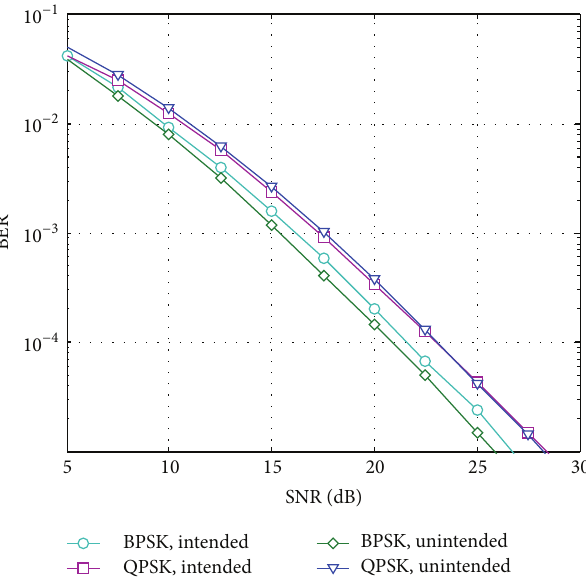
Figure 5: BER of the intended and unintended symbols for 𝑛 𝐸 = 1 and both BPSK and QPSK modulation schemes.